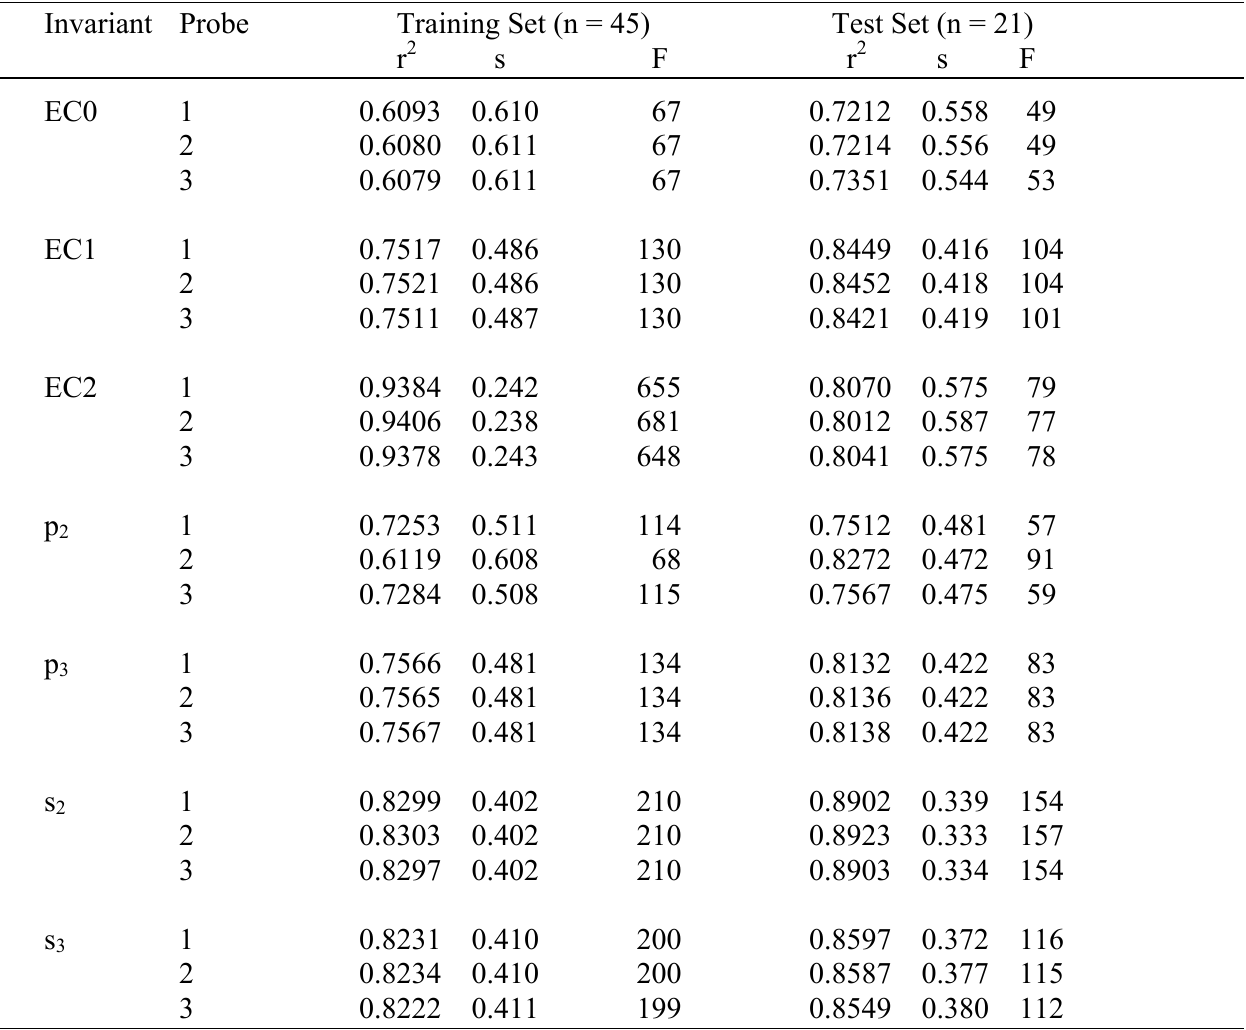
Table 2 . Statistical characteristics of linear OCWLI models of log(IGC 50-1 ) derived from LHFG invariants correlation